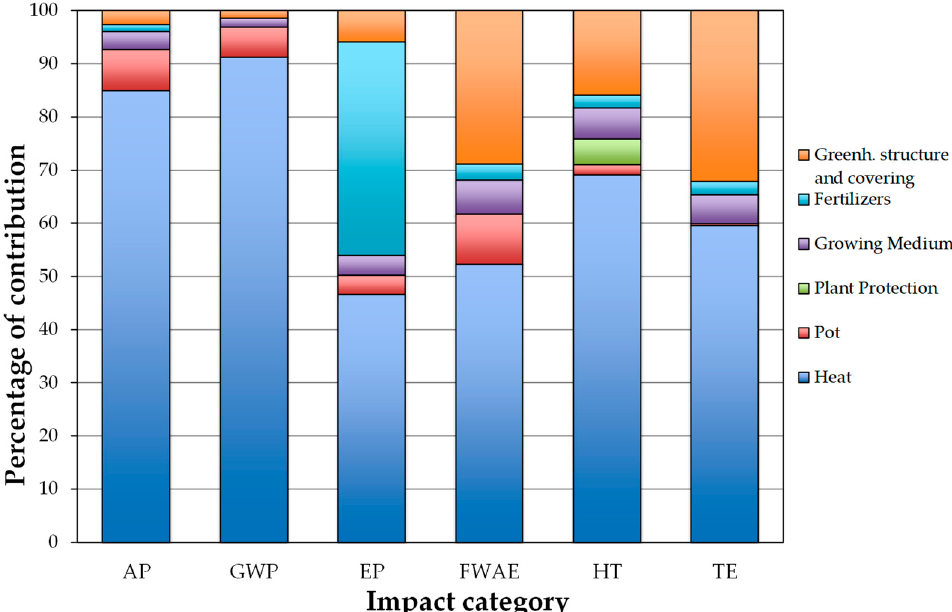
Figure 2. Relative contribution of different inputs for zonal geranium potted plant production. The impact categories assessed are: AP, GWP, EP, FWAE, HT and TE.